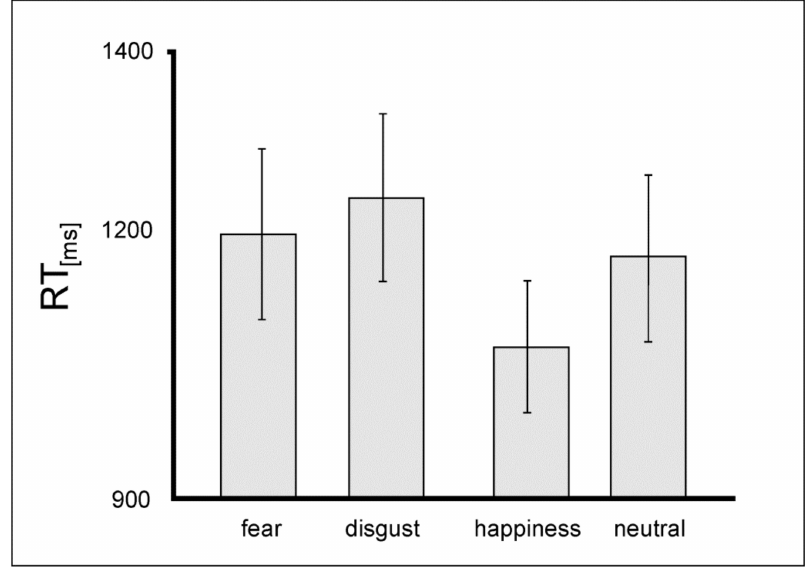
Figure 2. Mean reaction time (RT) values (in ms) for performance in the implicit task for patients. Error bars show standard errors